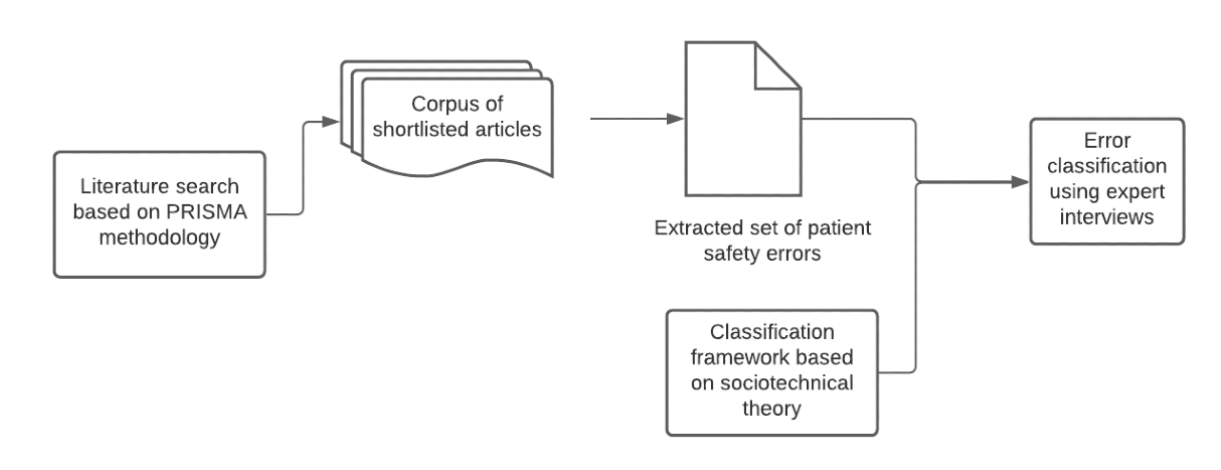
Figure 2. Research